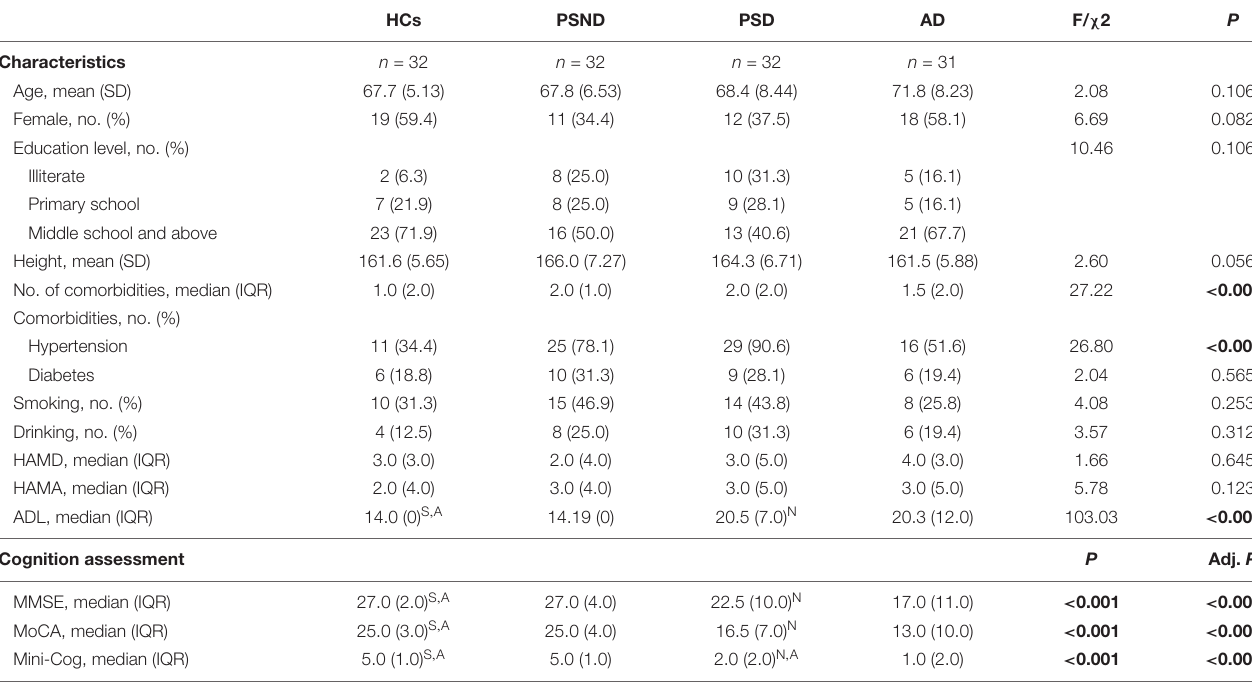
FIGURE 1 | The toe-off angle (ToA) and heel-to-ground angle (HtA) in the gait cycle. TABLE 1 | Baseline characteristics of participants stratified by included